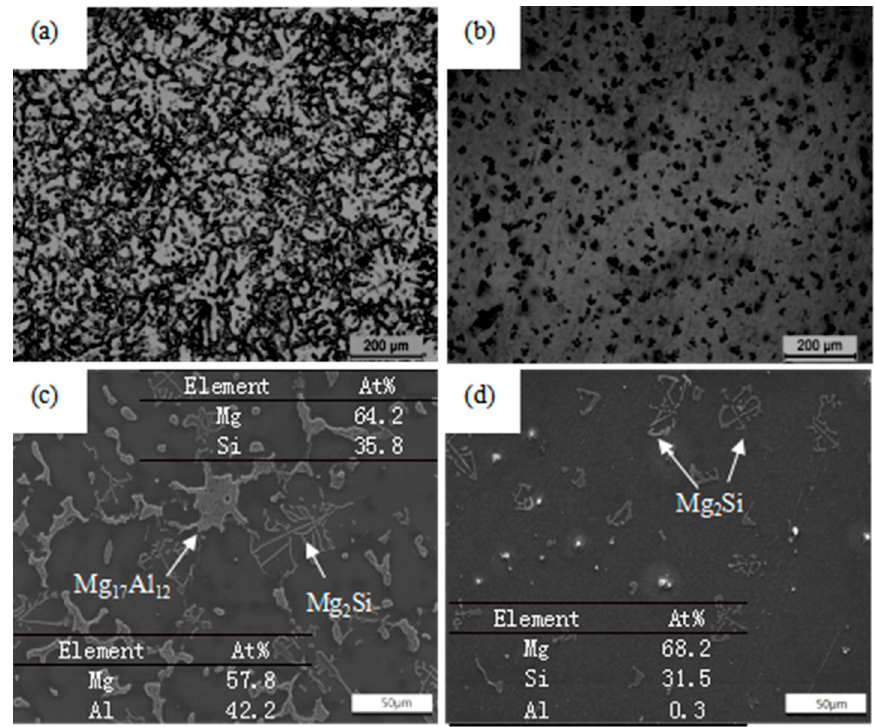
Figure 2. Optical, SEM (scanning electron microscope) micrographs, and EDS (energy dispersive spectrometer) results of Mg-9Al-1Si-1SiC composites prior to ECAP: ( a , c ) without HT (homogenization treatment); ( b , d ) with HT.